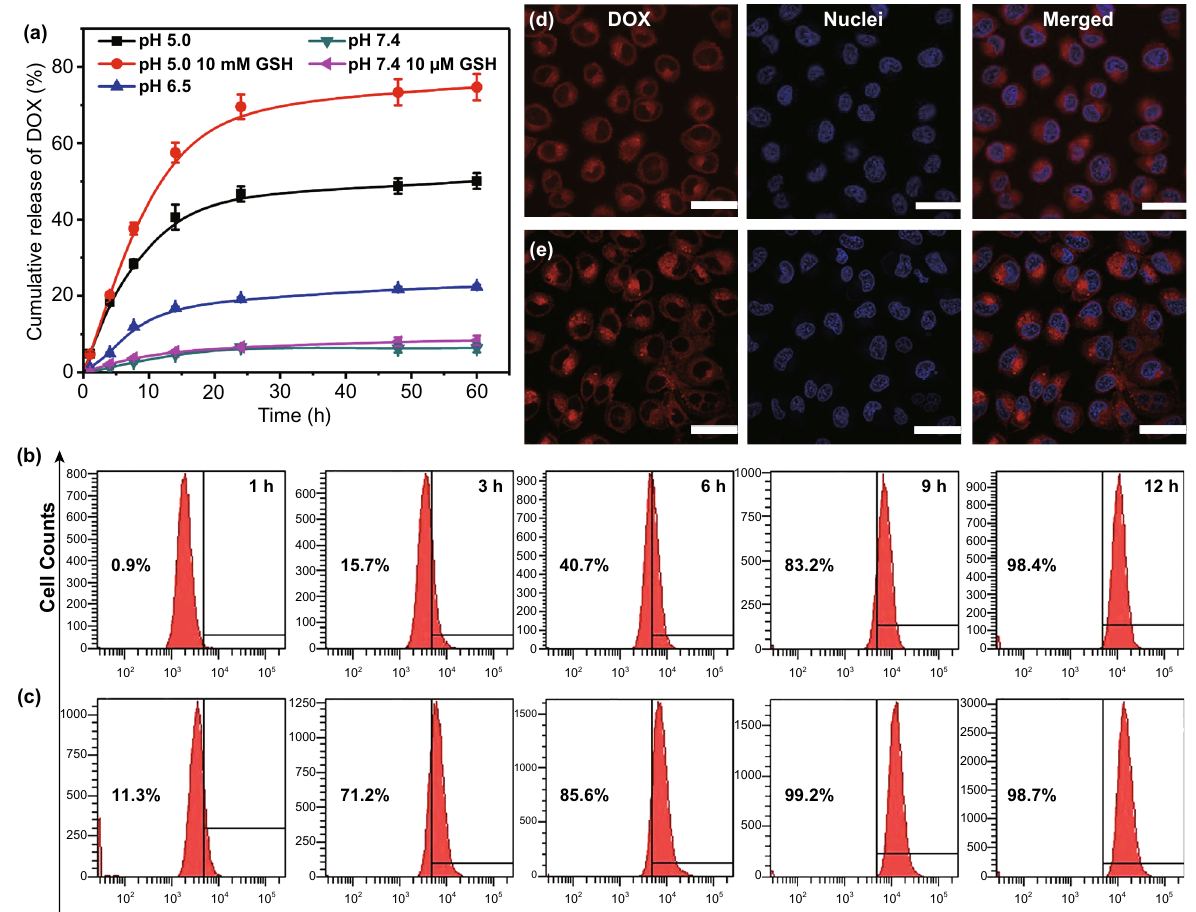
Fig. 4 a Cumulative release of DOX from DOX-loaded PAA 68 – b –PEG 86 – b –PAA 68 /MnO 2 in simulated body fluids. b Intracellular DOX release from DOX-loaded PAA 68 – b –PEG 86 – b –PAA 68 /MnO 2 in MCF-7 cells over a range of different times. c Free DOX used as control group. d CLSM visualization of cellular DOX release from DOX-loaded PAA 68 – b –PEG 86 – b –PAA 68 /MnO 2 after incubation for 9 h. e Free DOX used as control group, scale bar: 50 μm. For CLSM and flow cytometric analyses, equivalent DOX dose was 2.5 μg mL